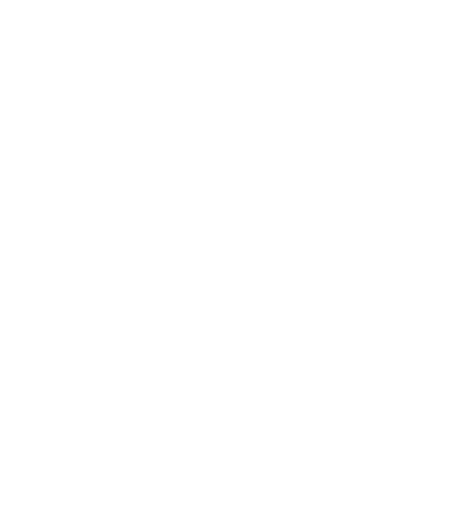
Table 4. Cost of inputs and price of